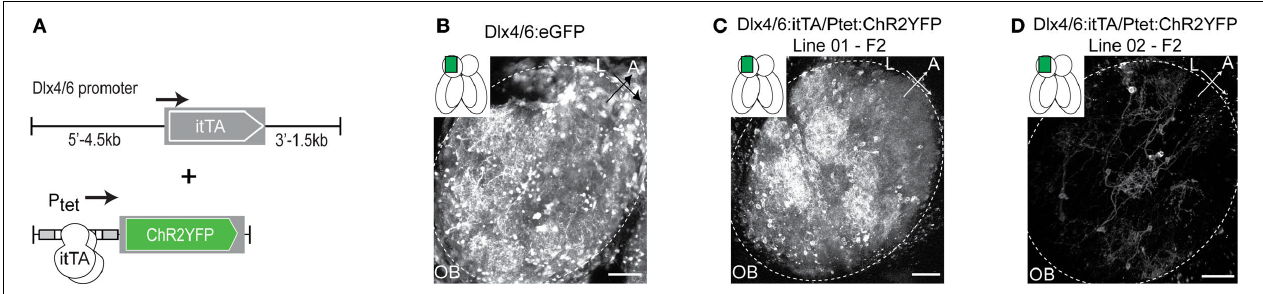
FIGURE 3 | Expression patterns in Tet system transgenics using a second promoter. (A) Constructs used to express the transactivator (itTA) under the control of the Dlx4/6 promoter and ChR2YFP under Ptet control. (B) GFP expression in the adult OB of Dlx4/6:eGFP transgenic fi sh generated by